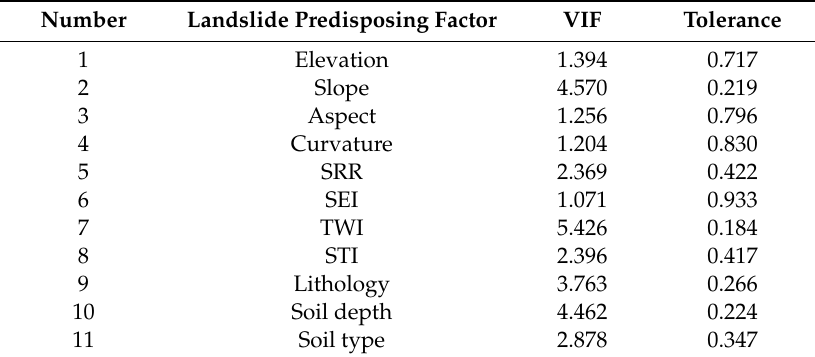
Table 3. Multicollinearity analysis for the landslide predisposing factors.